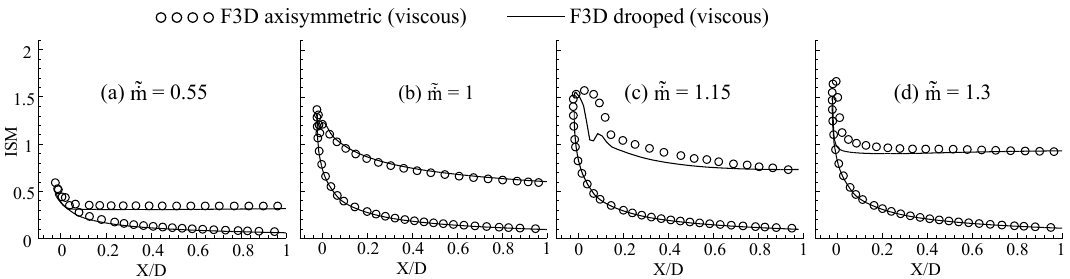
Figure 5. Axial variation of isentropic Mach number (ISM) for free 3D (F3D) drooped and axisymmetric viscous simulations.